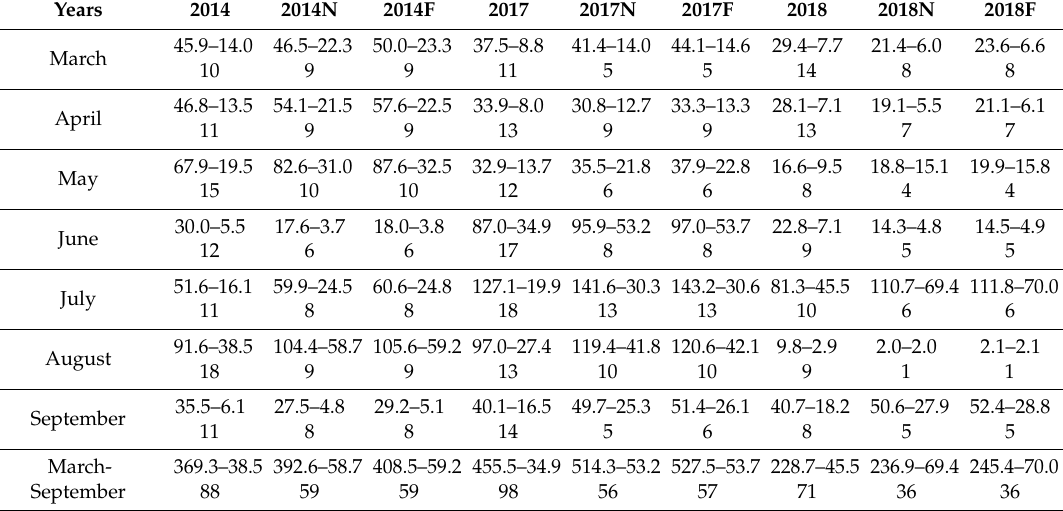
Table 5. Results of precipitation modification (numerator presents the values of precipitation sums and maximum daily precipitation, whereas the denominator shows the number of days with daily precipitation above 0.1